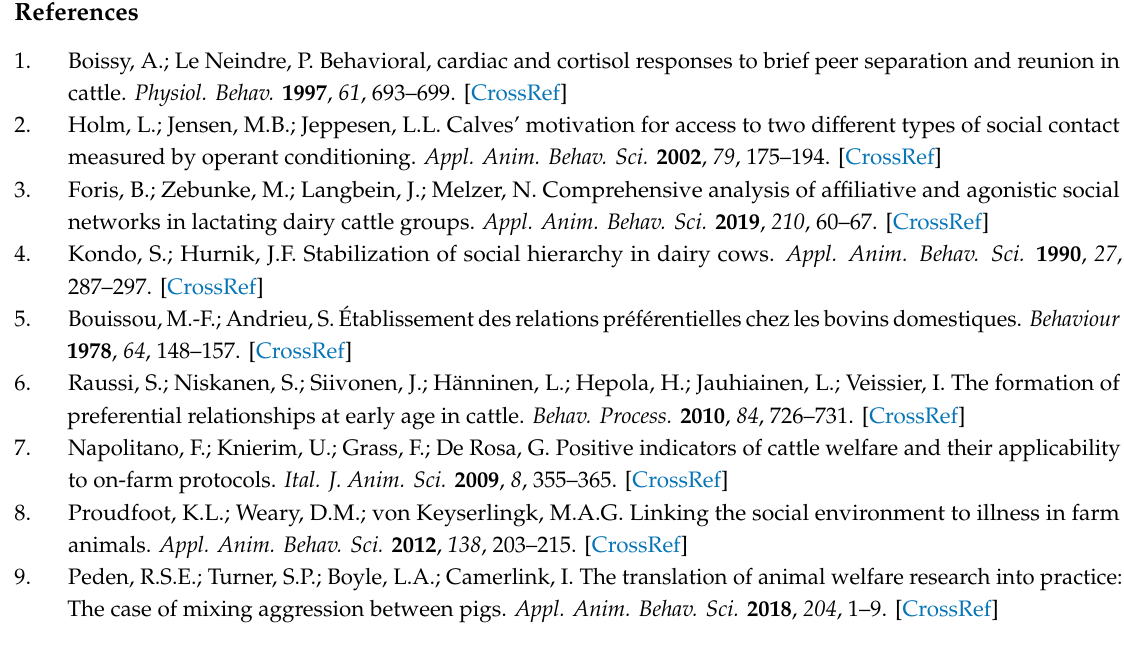
Table S1: ICC of the two observers of agonistic behaviors, Table S2: Temporal distribution of each agonistic behavior, Supplementary Data 1: Raw data used for statistical analysis, Supplementary File 1: Description for Supplementary Data 1, Supplementary File 2: R script for statistical